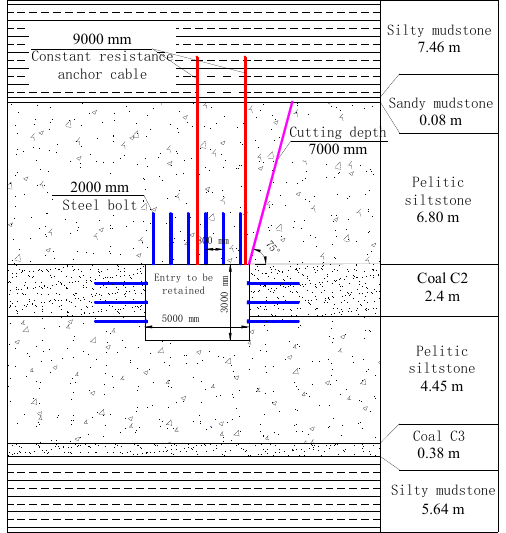
Figure 5. Roof-cutting design drawing.